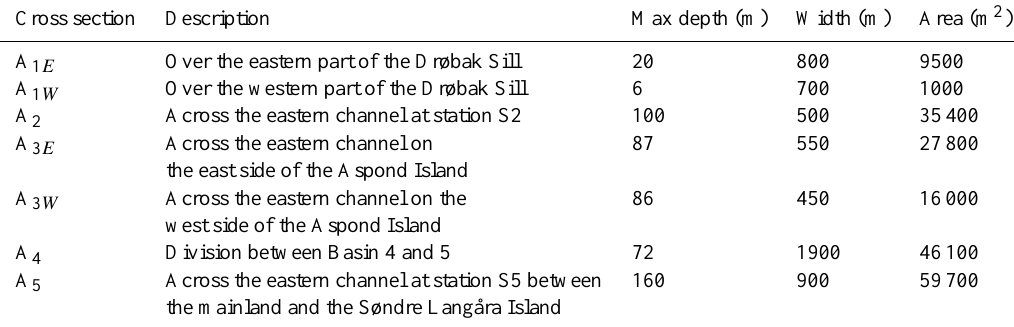
Table 3. Selected cross-sectional areas in the inner Oslofjord (see Fig. 13). Cross section Description